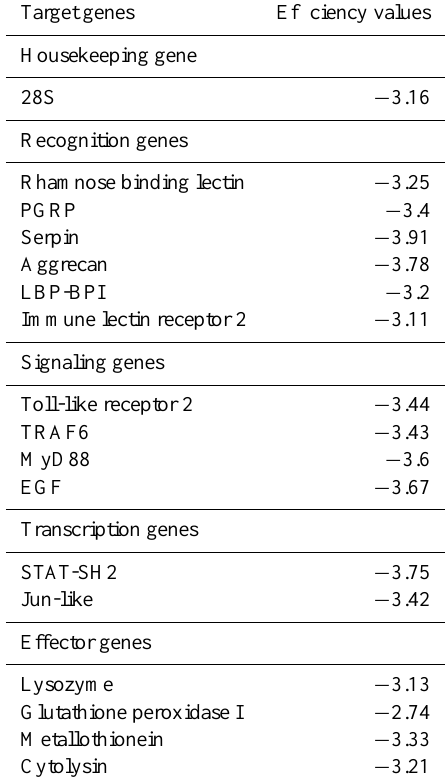
Table 2. Efficiency values for target genes according to the immune functional categories, Recognition, Signaling, Transcription and Ef- fector